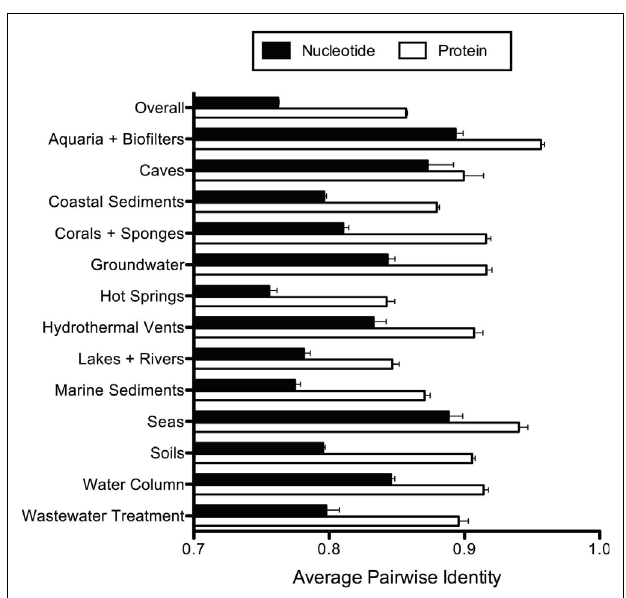
FIGUREA1 |Average pairwise amoA nucleotide and protein sequence identity. Error bars represent the standard error of the